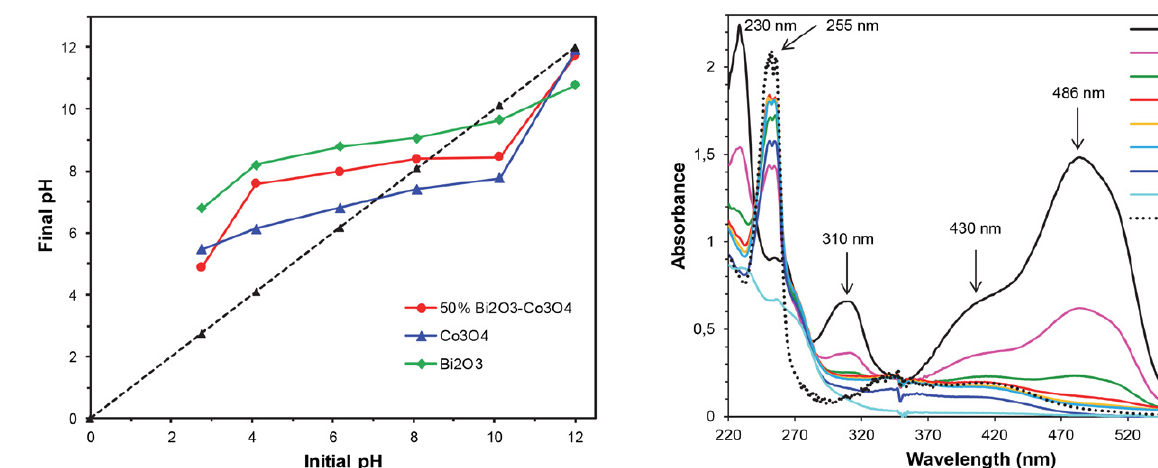
Fig. 8. pH drift method to obtain the pH pzc of the as-prepared oxide systems. The dashed line applies to the system without added catalyst